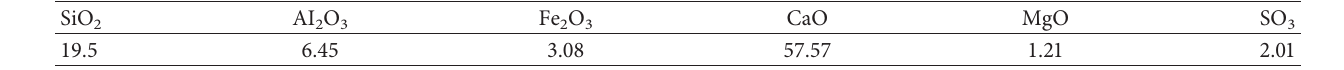
Table 1: Chemical compositions of cement (unit: